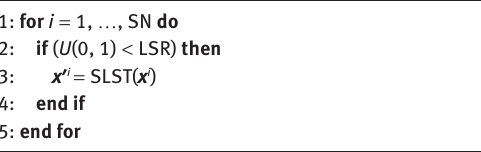
Algorithm 3: Employed Forager-Triggered LST